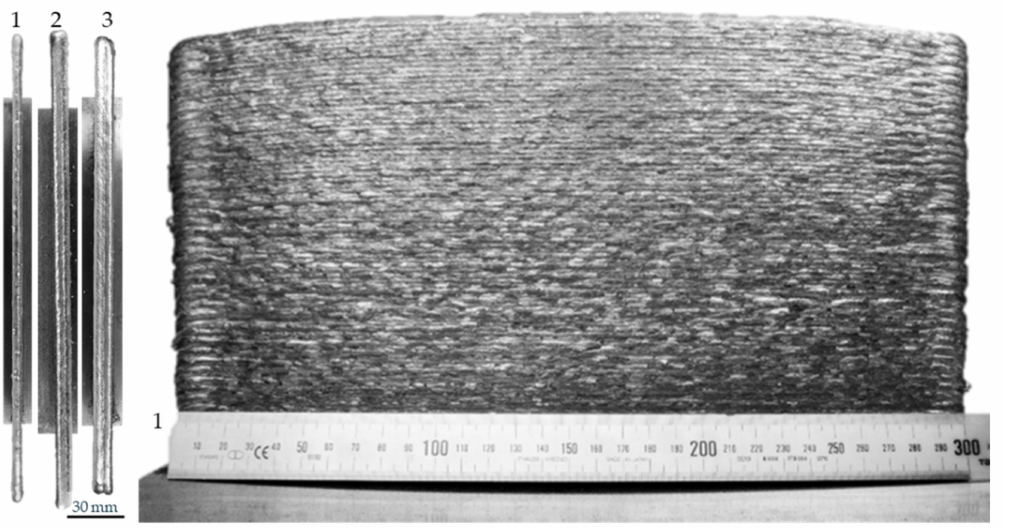
Figure 7. Samples of additively manufactured wall structures 4 kJ/cm: (1) single weld track; (2) two adjacent weld tracks; (3) three adjacent weld